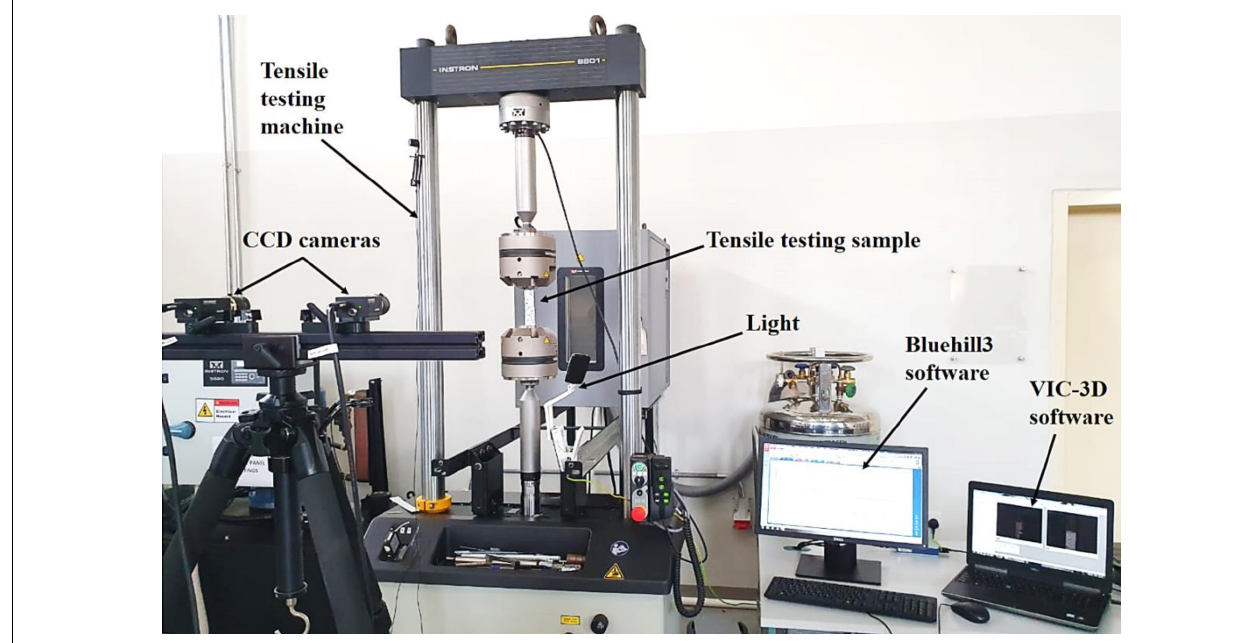
FIGURE 2 | The tensile test setup with a 3D-DIC system for the determination of mechanical properties of